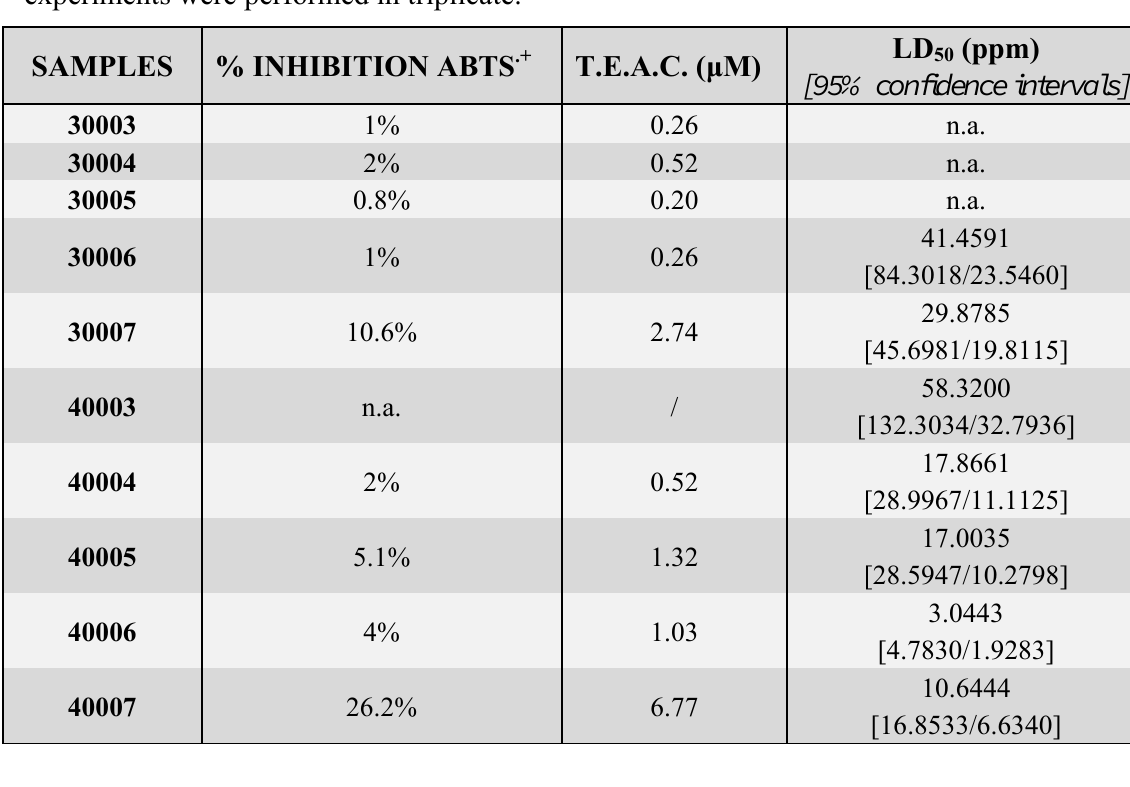
Table 1. Biological activity of compounds 30003 - 30007 and 40003 - 40007 . The experiments were performed in